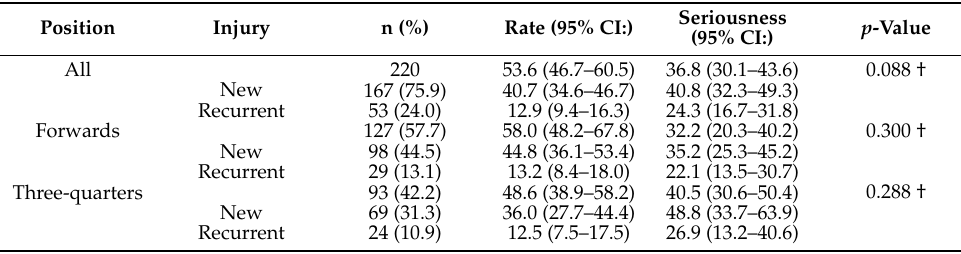
Table 8. New vs. recurrent